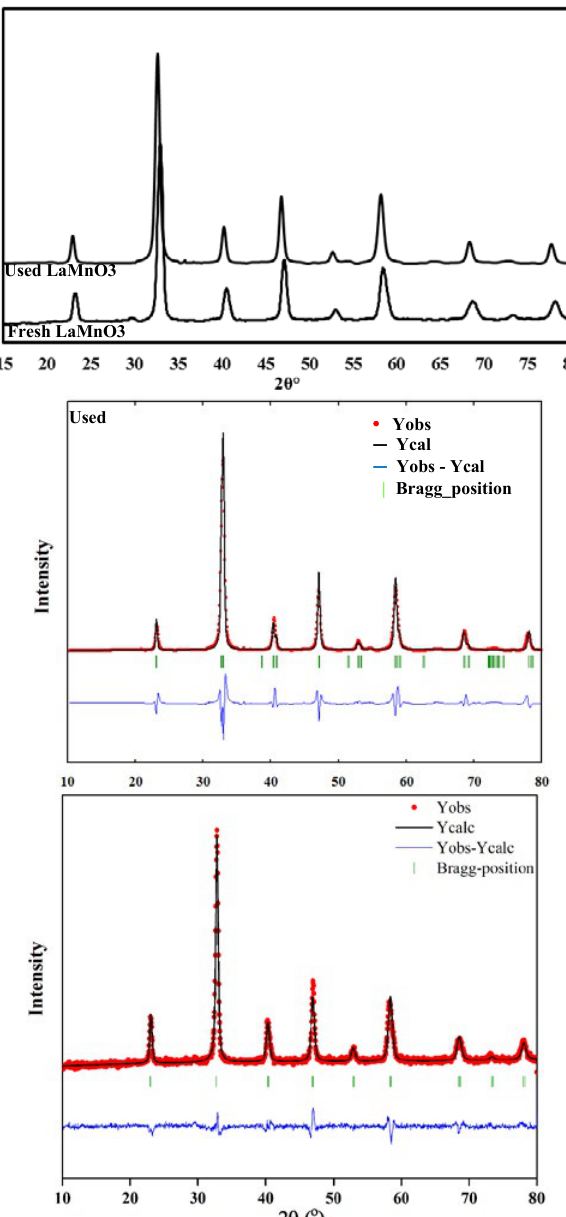
Fig. 2. The XRD patterns of the fresh and used samples and their Rietveld analysis. The circle signs represent the raw data. The solid line represents the calculated profile. Vertical bars indicate the position of Bragg peaks for the cubic LaMnO is the difference between the observed and the calculated